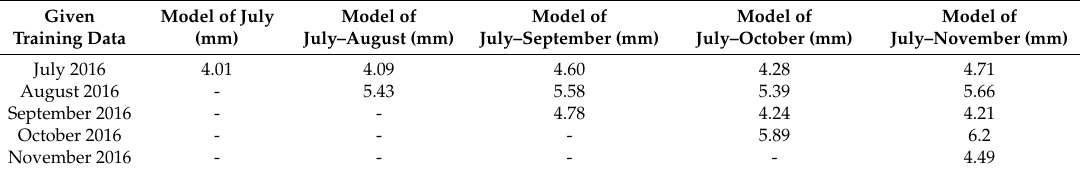
Table 2. RMSE values with respect to different sets of training data.